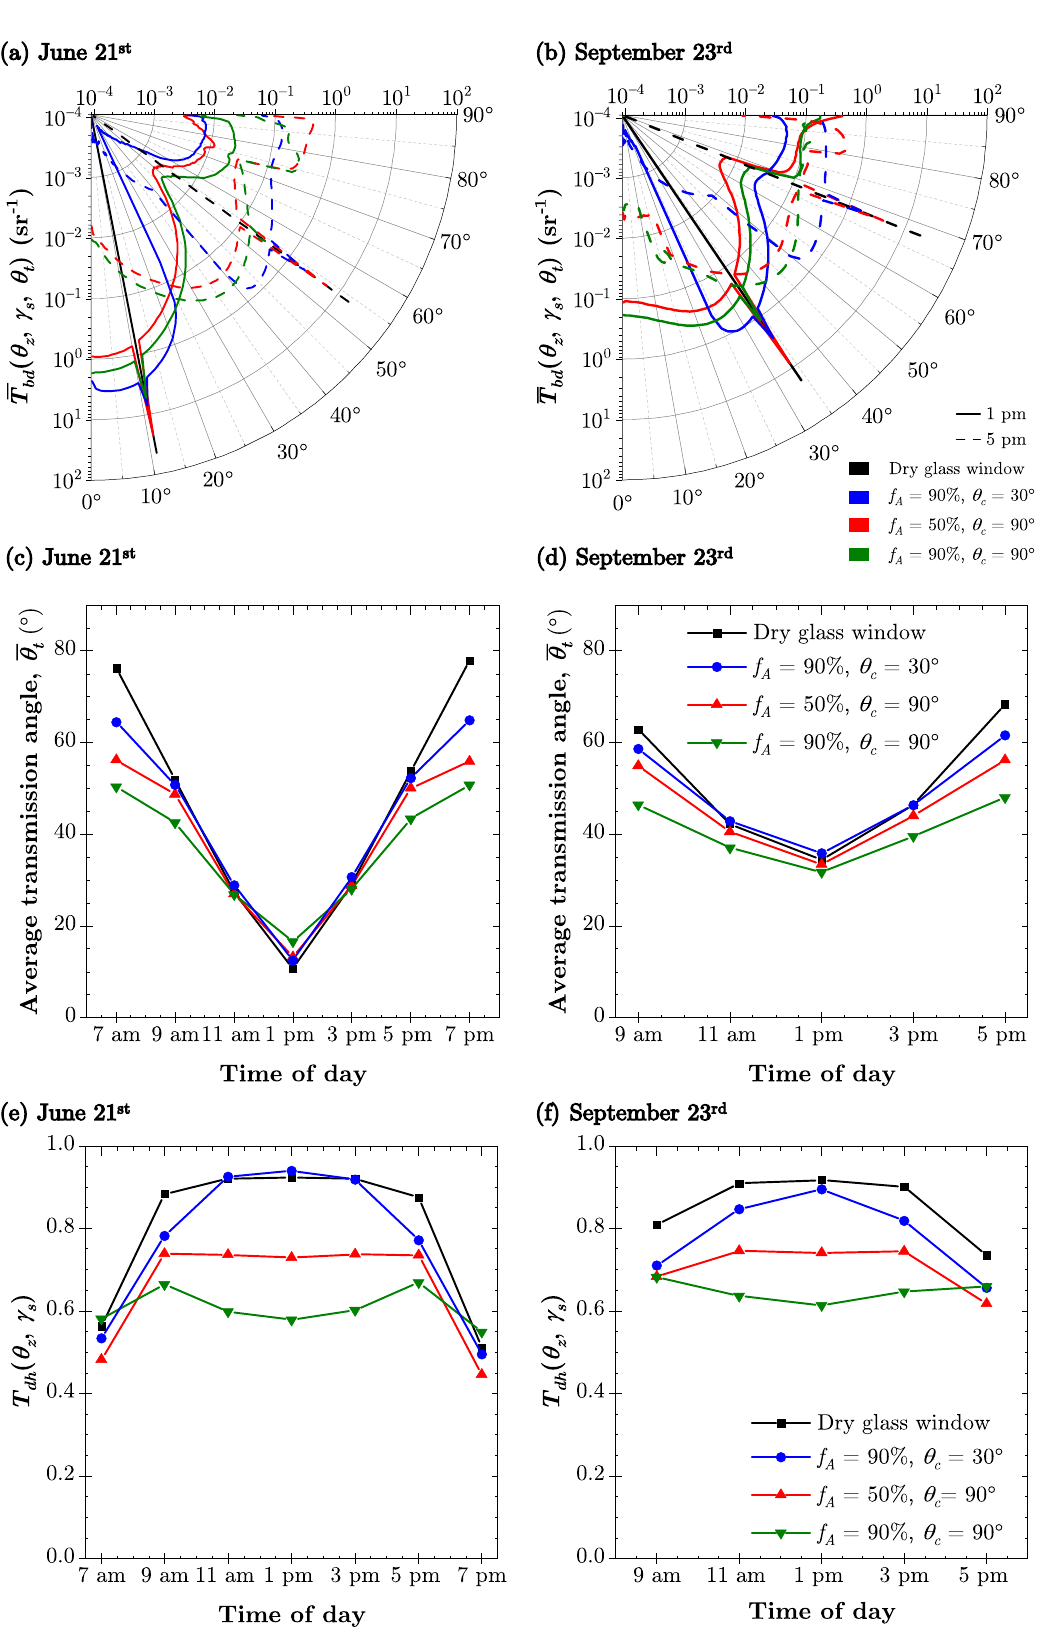
Figure 5. One-dimensional bidirectional transmittance ¯ T bd at 1 p.m. and 5 p.m. ( a , b ), average transmission angle ¯ θ t ( c , d ), and directional-hemispherical transmittance T dh ( θ z , γ s ) ( e , f ) as functions of time for a variety of window conditions on ( a , c , e ) 21 June and ( b , d , f ) 23